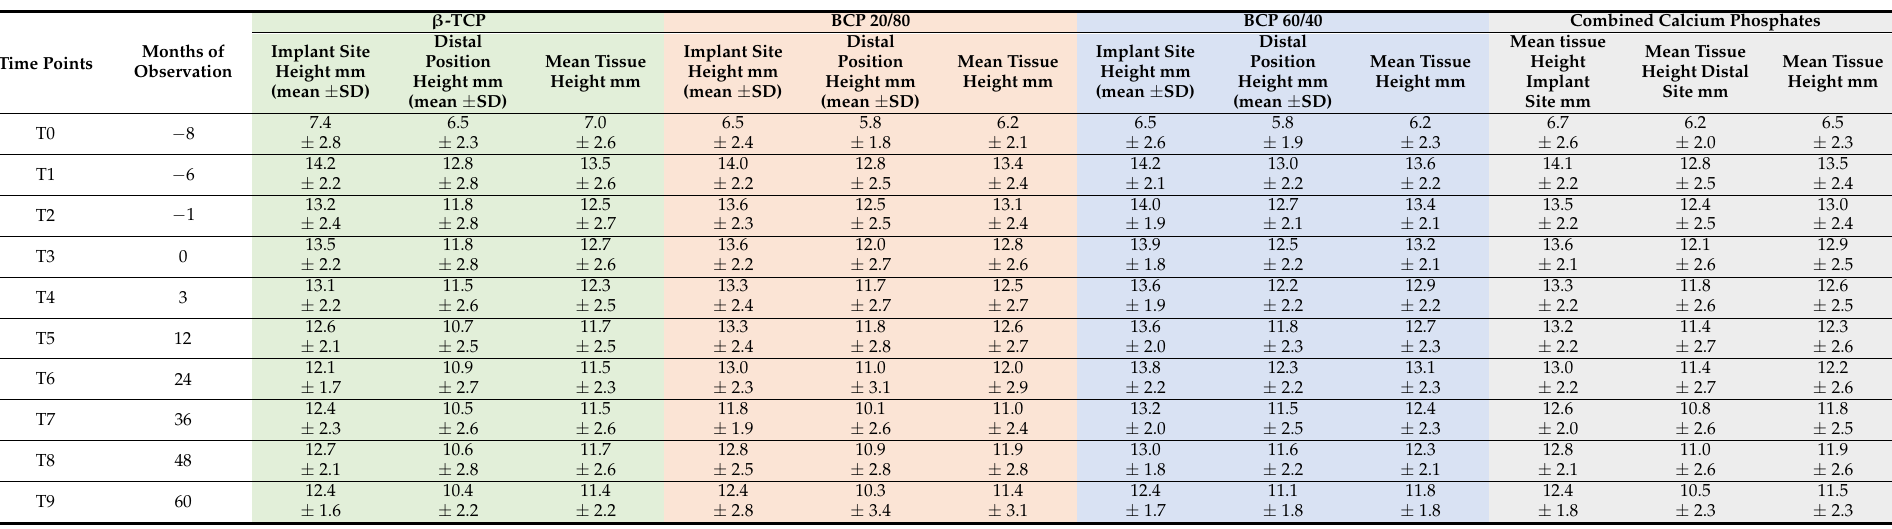
Table 4. Individual and combined tissue height measurements (in mm) of 512 sites (256 implant site and 256 distal positions) of three types of calcium phosphate bone substitutes in maxillary sinus floor elevation (MSFE), after 5-year follow-up. β -TCP— β -tricalcium phosphate; BCP—biphasic calcium phosphate; HA—hydroxyapatite; T0—patient intake;